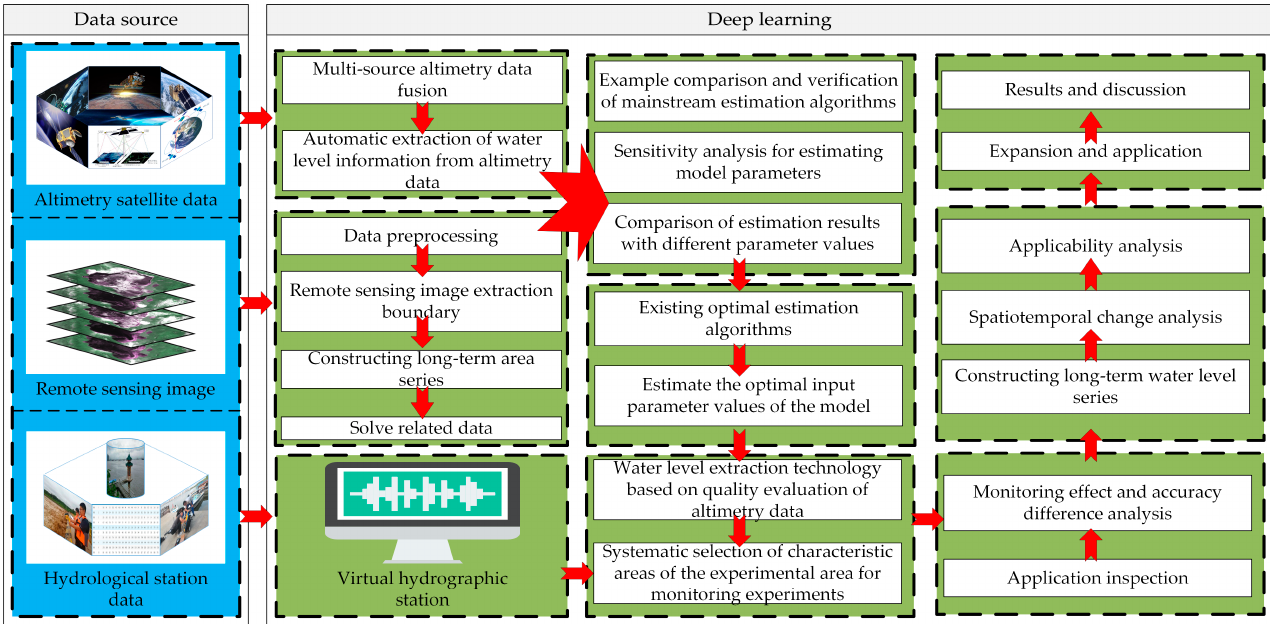
Figure 7. The whole process of inland lake monitoring based on deep learning.